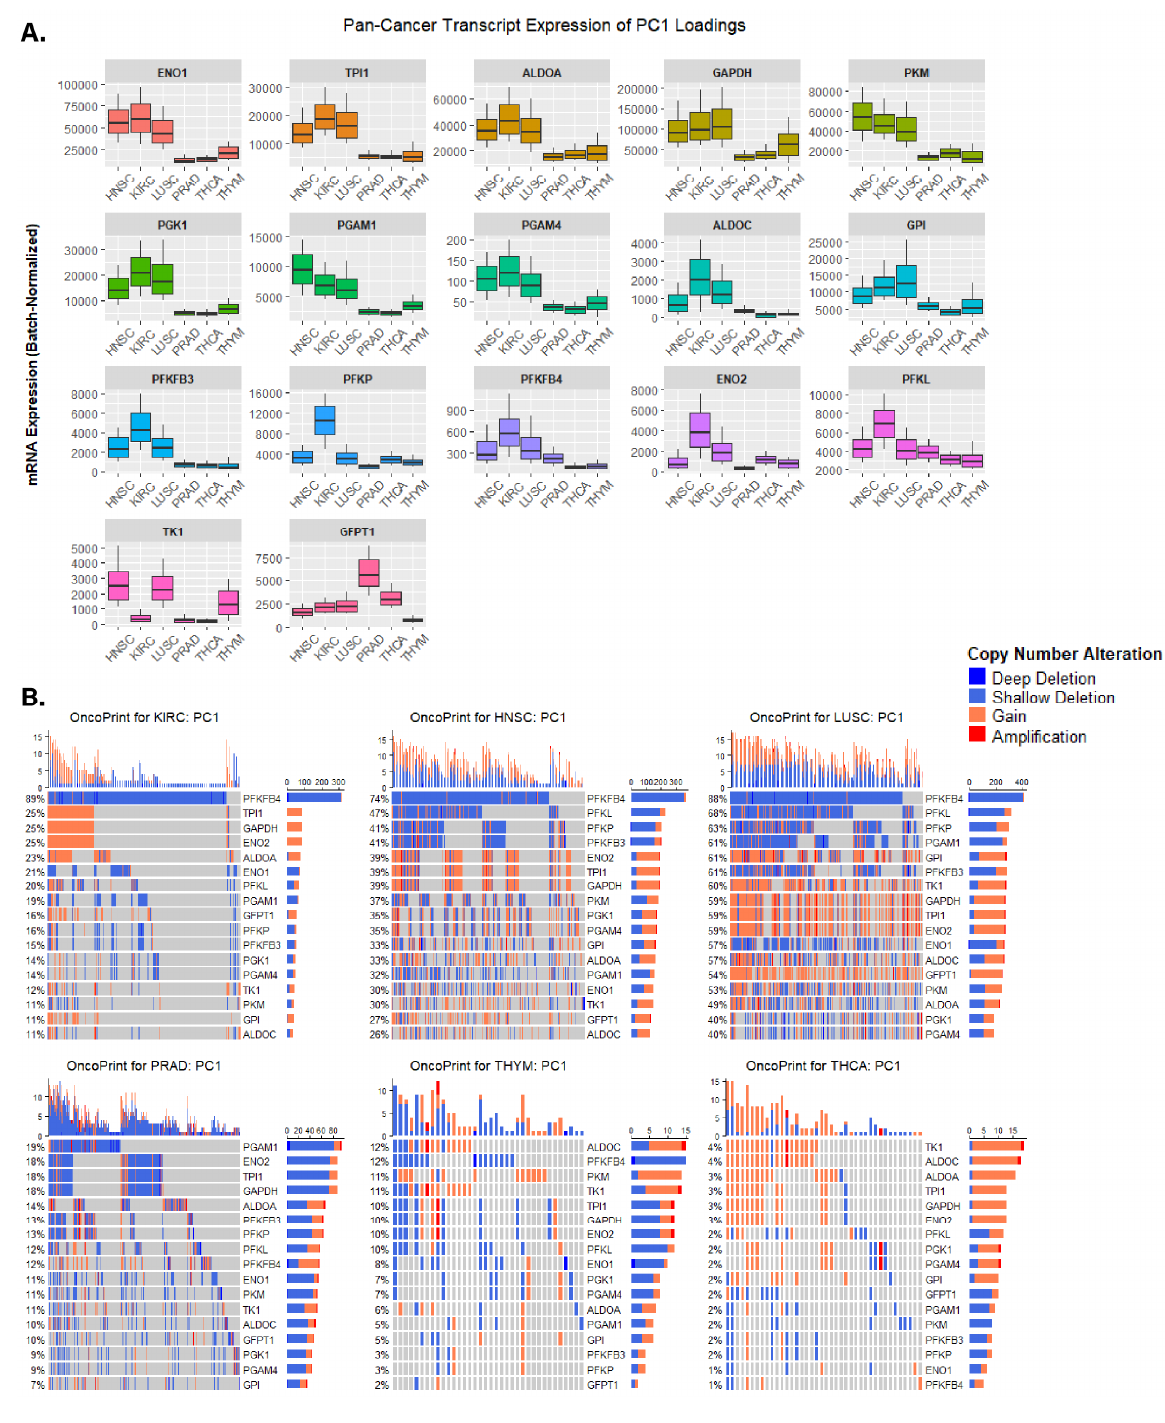
Figure 4. mRNA and CNA profiles for PC1 loadings across the variably glycolytic pan-cancer cohort. ( A ) Boxplots showing transcript expression distributions of sPCA’s PC1 loadings across cancer cohorts. Due to excessive variability in bulk mRNA expression across all samples, the top and bottom 10th percentiles were excluded here. ( B ) Oncoprints of CNAs in PC1 loadings across the cancer